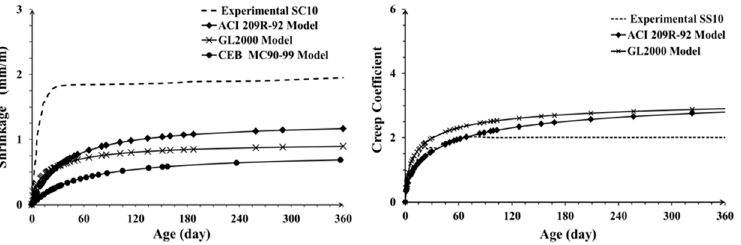
Figure 1. The predicted shrinkage of mix SC10 ( left ) and the predicted creep coefficient of mix SS10 ( right